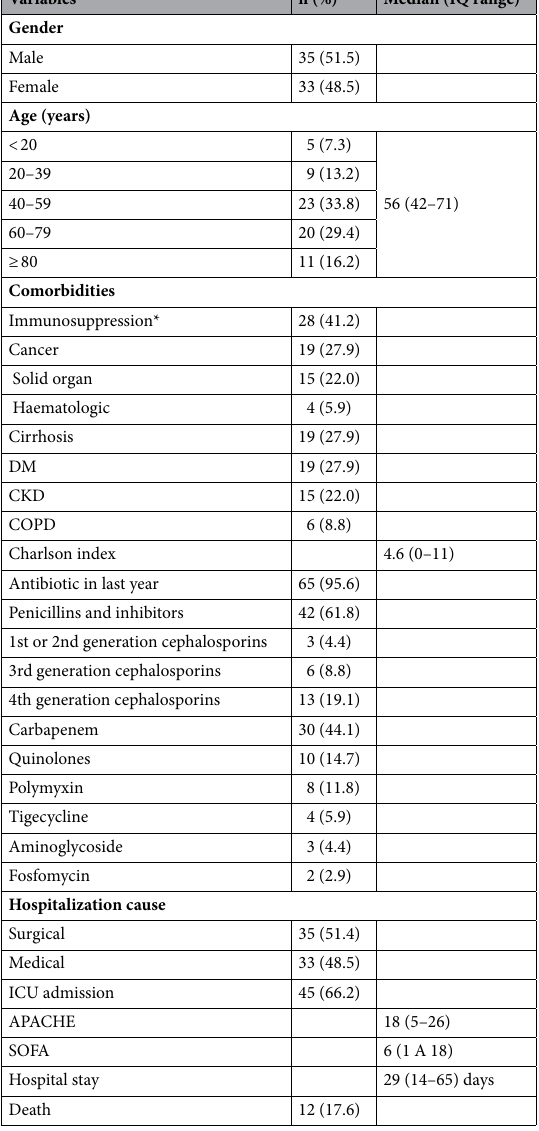
Table 1. Clinical characteristics of the 69 hospitalized patients with KPC- Kp isolates during 2014–2016. DM diabetes mellitus, CKD chronic kidney disease, COPD chronic obstructive pulmonary disease. *Patients with immunosuppression except